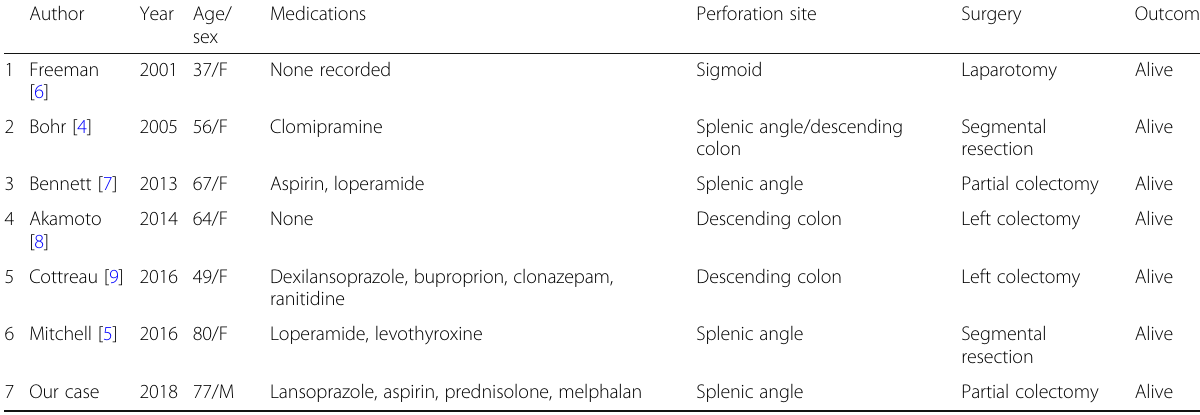
Table 1 Reported cases of spontaneous perforation in collagenous colitis